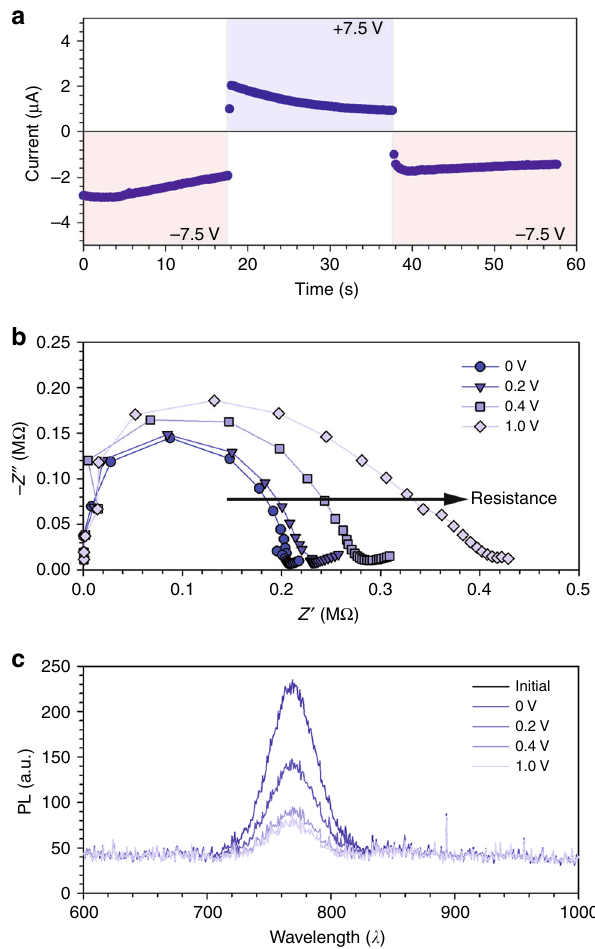
Fig. 3 Physical measurements of the biased perovskite fi lms. a Current decay curves as a function of the polarity of the applied voltage on a CH 3 NH 3 PbI 3 – x Cl x perovskite fi lm with ± 7.5 V across an ~150 μ m channel. A change in polarity maintains the current with a different sign, indicating that ionic transport is modifying the bulk properties of the perovskite. b Complex impedance plot of an interdigitated electrode measured in the dark as a function of the applied DC bias. c PL decay in intensity of the device measured in